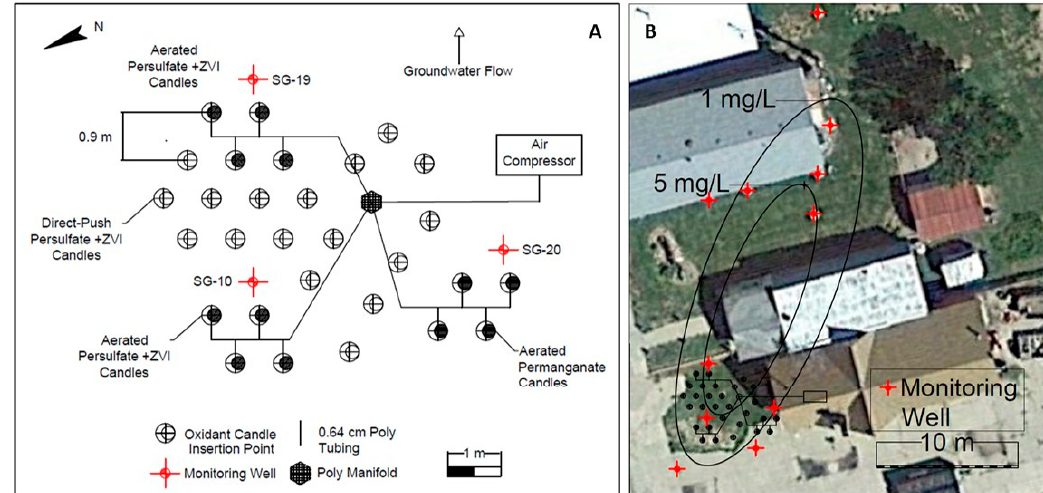
Figure 3. ( A ) Plot plan of Freeman site showing location of monitoring wells and direct-push oxidant candles, with and without aeration and ( B ) plan view of Freeman site showing locations of xylene plume and oxidant drive points (circled). Water 2020 , 12 , x FOR PEER REVIEW